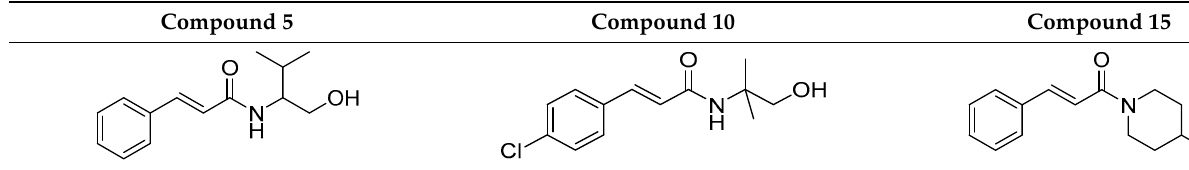
Table 1. Chemical structures of the tested compounds.